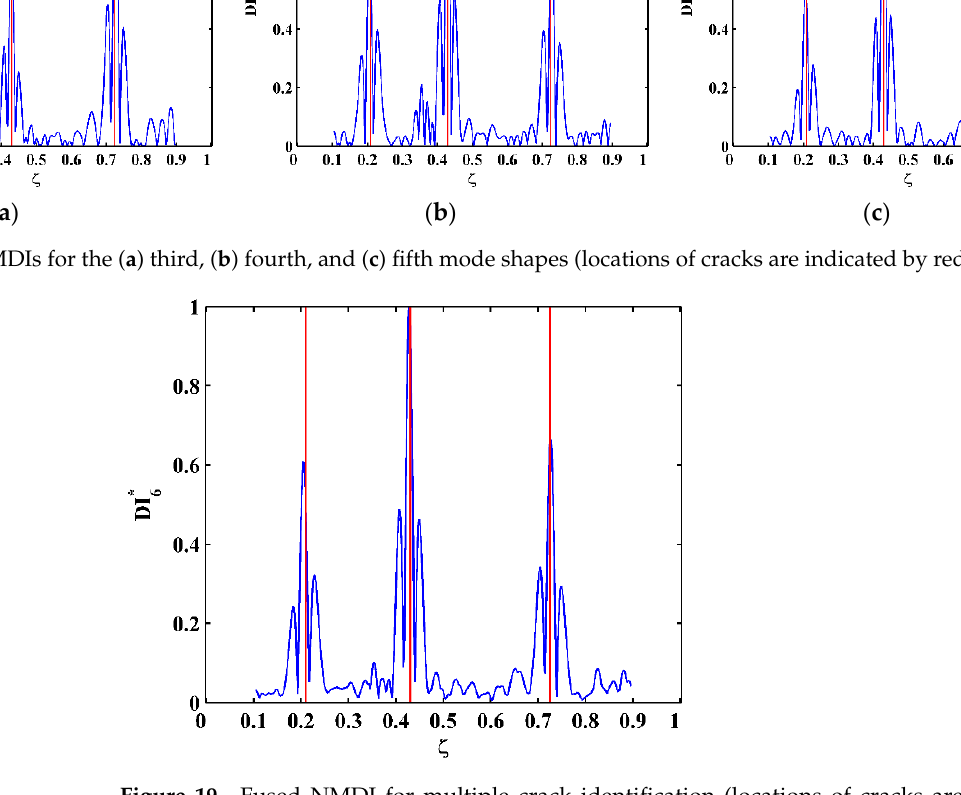
Figure 19. Fused NMDI for multiple crack identification (locations of cracks are indicated by red lines).